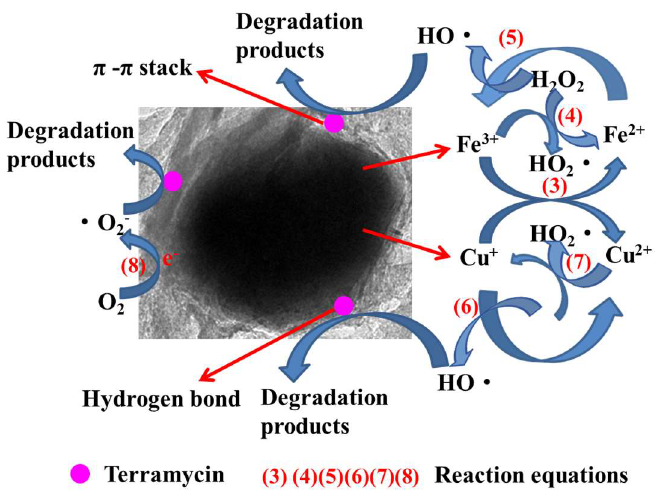
Figure 8. Degradation mechanism diagram.